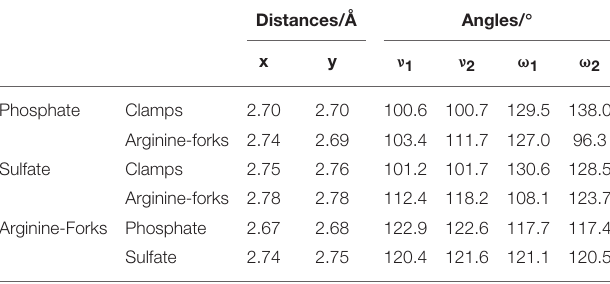
TABLE 2 | Distances (in Ångström) and bond angles (in degree) involved in the formation of clamps and arginine-forks using the BHandH